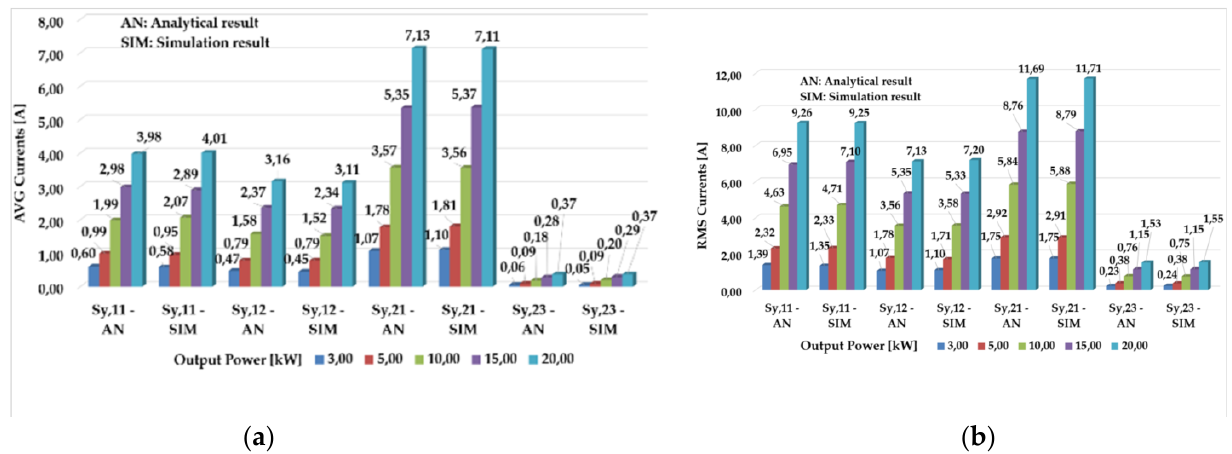
Figure 12. Comparison between the analytical and simulation approaches of the currents flowing in the power semiconduc- tors located in the 3 Φ 5L E-Type MMI: ( a ) average (AVG); ( b ) root mean square